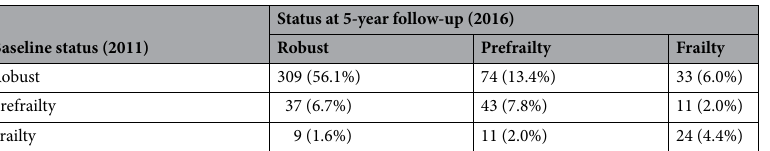
Table 2. Transitions in frailty status from the baseline to the 5-year follow-up. Data are shown as the number of cases (prevalence,